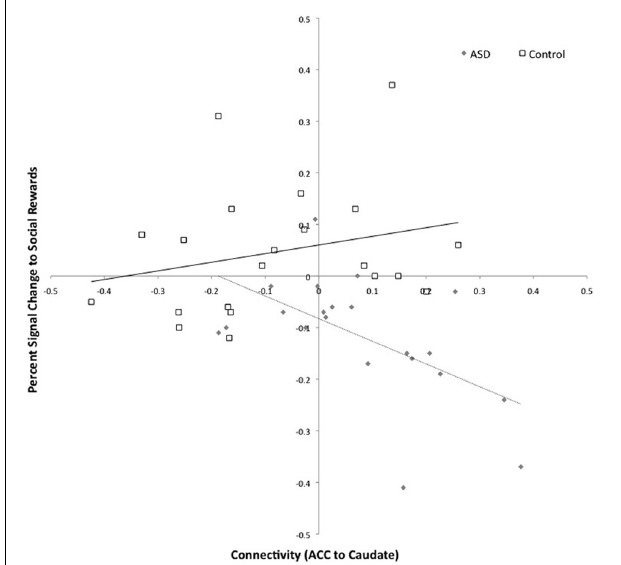
FIGURE 6 | Connectivity between the left caudate and right anterior cingulate and activation to social rewards in the left caudate. Connectivity values are shown on the x -axis and percent signal change for social reward feedback is shown on the y -axis. The ASD group is shown in gray (with dashed trend-line) and the controls in white (with solid black